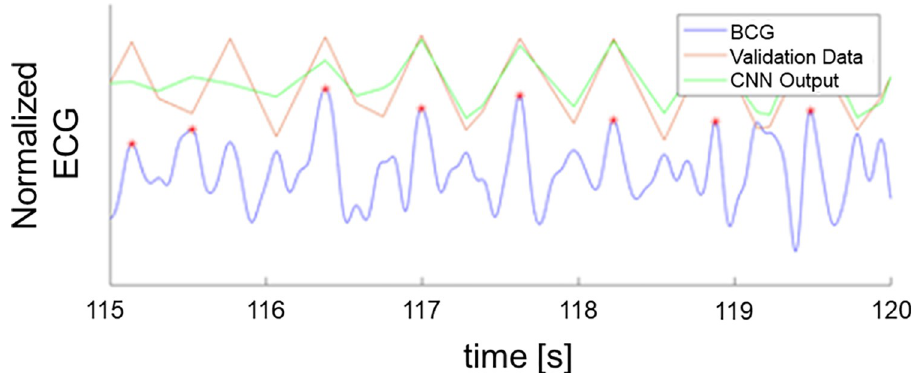
Fig 6. R-peaks estimation using CNN vs R-peaks from ECG signal.